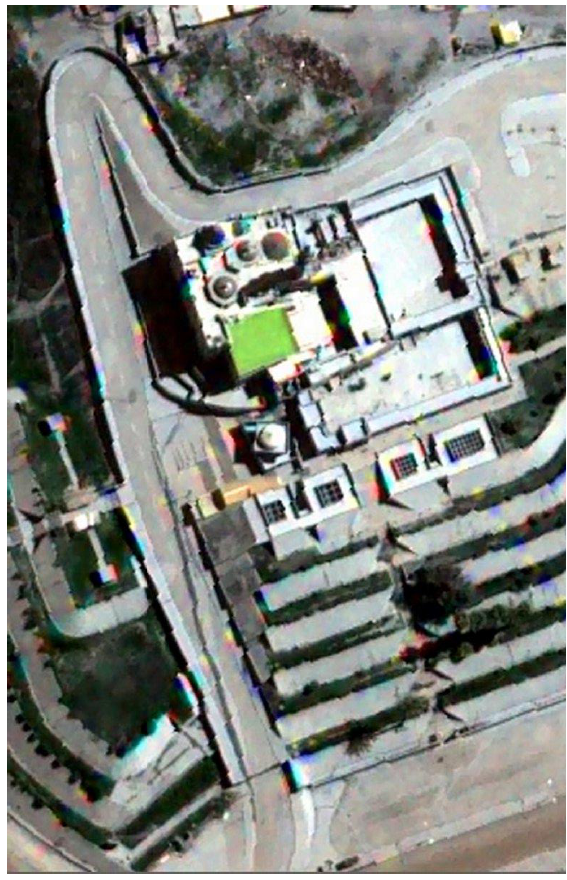
Figure 4. Mosque of Profet Nebi Yunus after the events satellite images acquired before the start of the destructions in 2010, then, on the same position on the “after” images the changes were